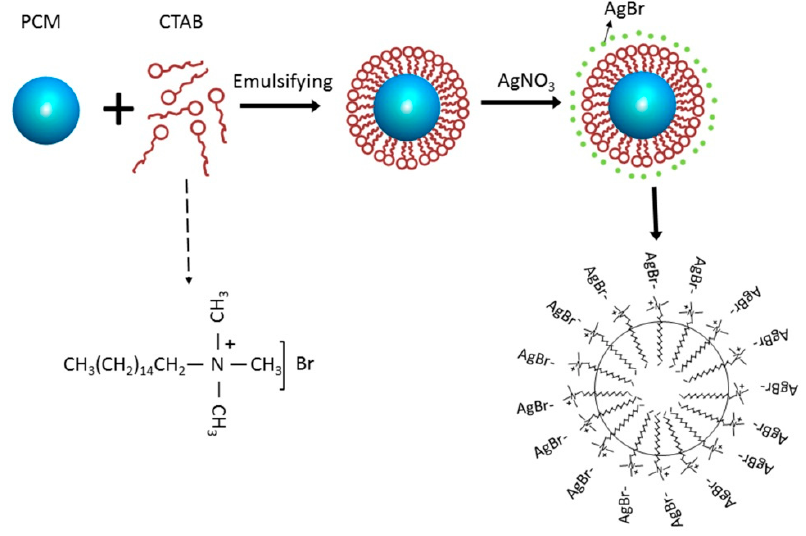
Figure 1. A synthesis schematic of the formation of fatty acid/AgBr micro/nanocapsules.